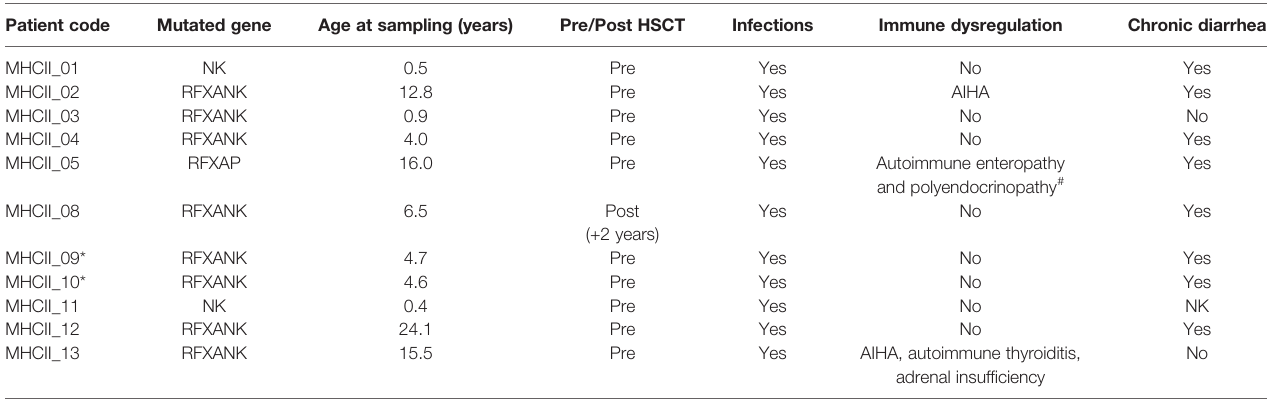
TABLE 2 | MHCII-D patients ’ features. Patient code